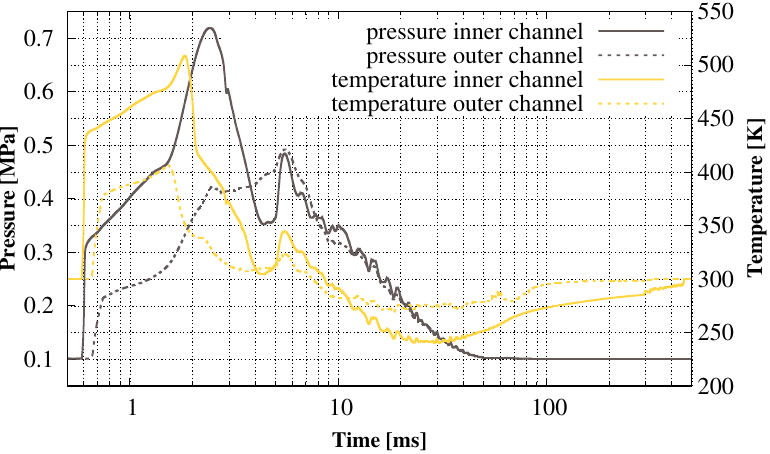
Figure 14. Outlet pressure and temperature time distribution. The aforementioned phenomena arising from changes in inlet and outlet parameters are confirmed by the contour plots given in Figures 15 and 16 as well as in Figure 17. Due to a large amount of data, only a portion of them is presented. The bottom part of the computational area is shown as a continuous point cloud. The upper part of the computational area shows contours for selected ten values from the entire spectrum of results for given parameters (i.e., pressure, temperature, Mach number). Both types of graphs are coloured according to the same scale shown below the snapshots. Only the most characteristic time moments have been selected.